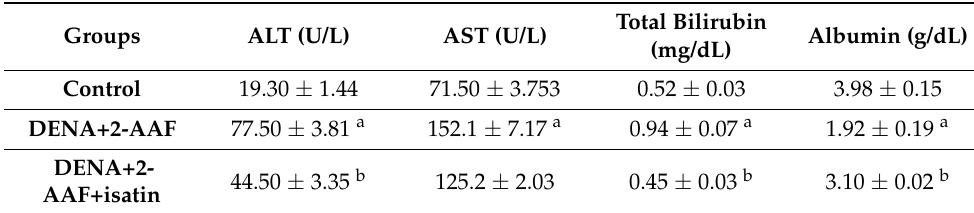
Table 1. Effects of isatin on serum ALT, AST, total bilirubin, and albumin levels in DENA/2-AAF- administered